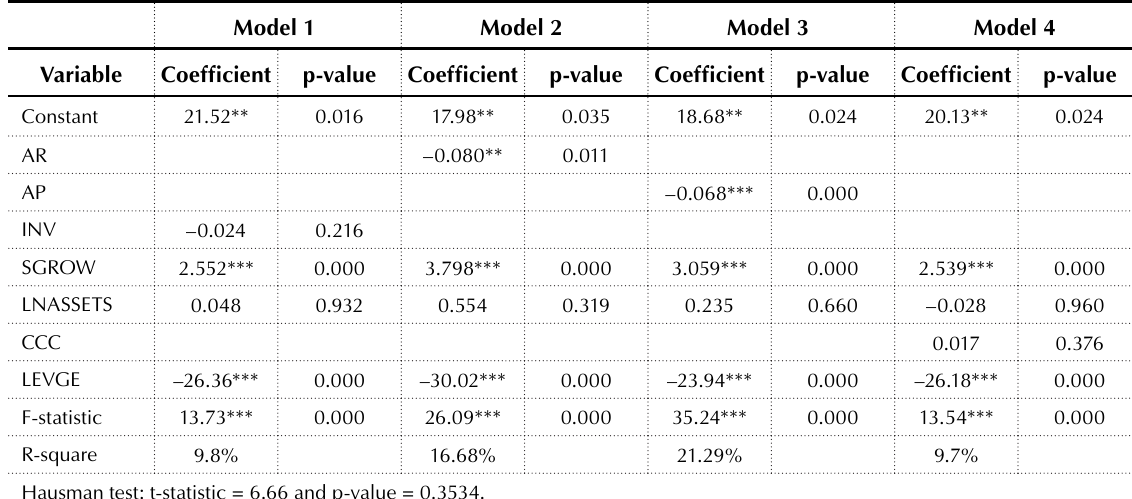
Table 3. Multivariate regression estimates for study models using